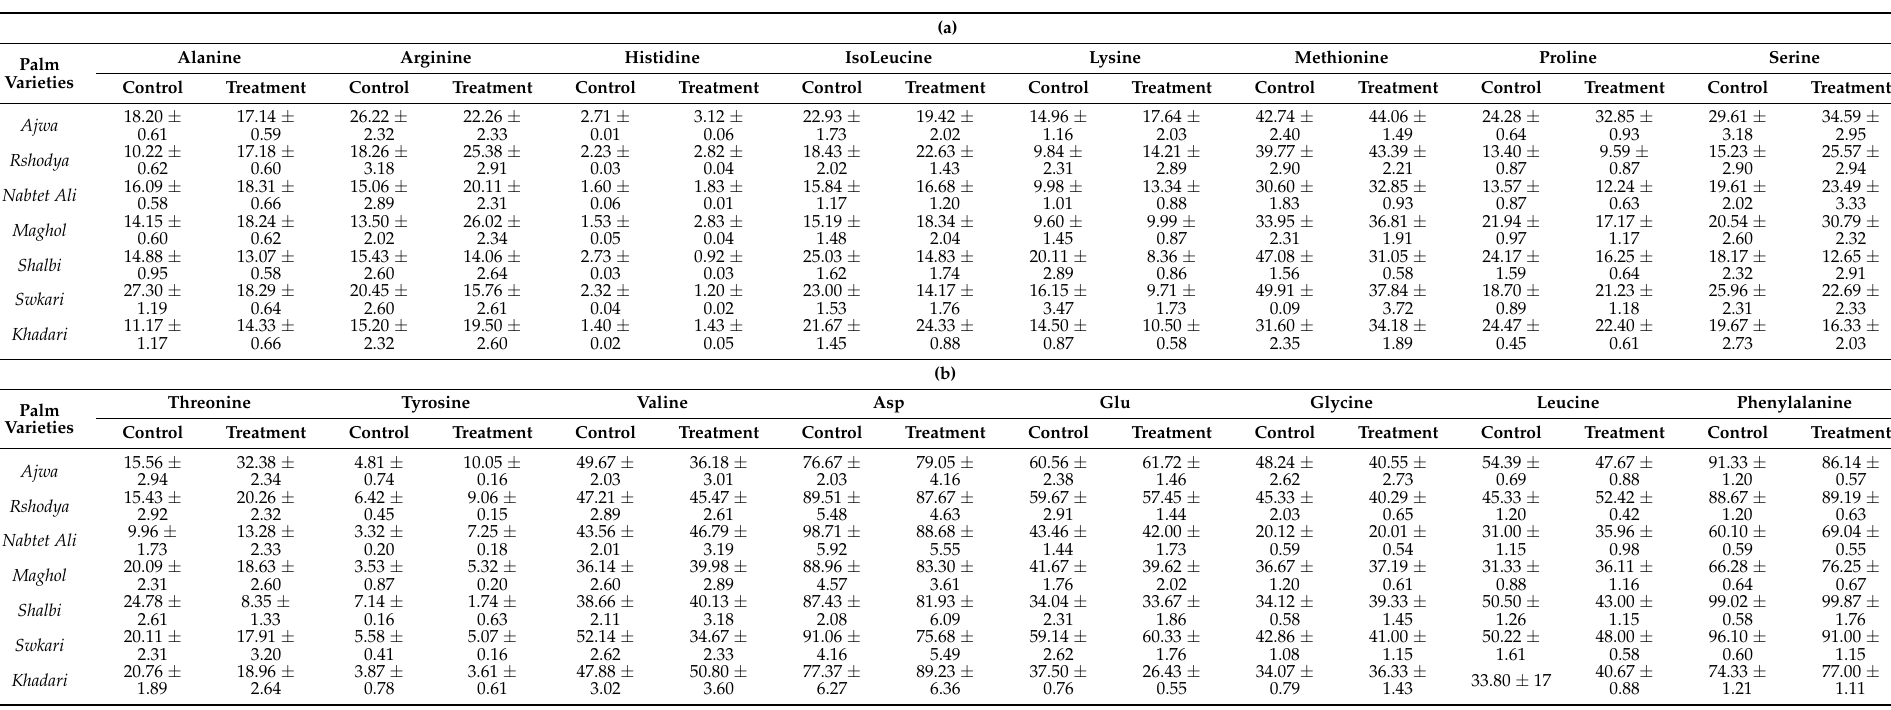
Table 3. ( a ) The influence of SDBD plasma on amino acids of different varieties of palm dates. ( b ) The influence of SDBD plasma on amino acids of different varieties of palm